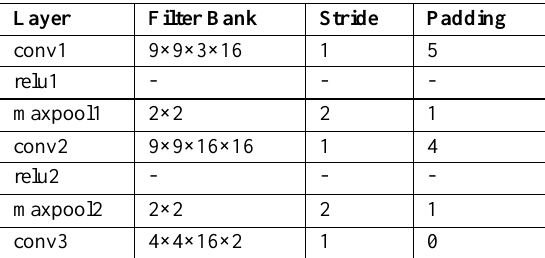
Table 1. Adopted CNN structure